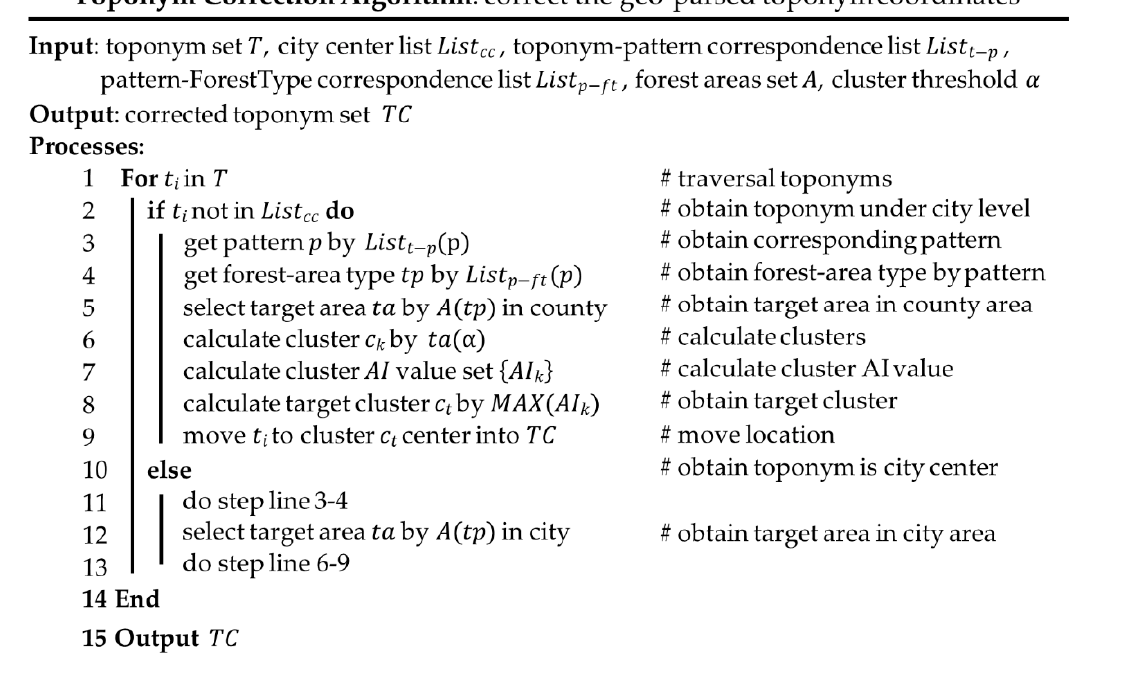
Figure 4. The logic flow of the toponym correction algorithm based on remote sensing